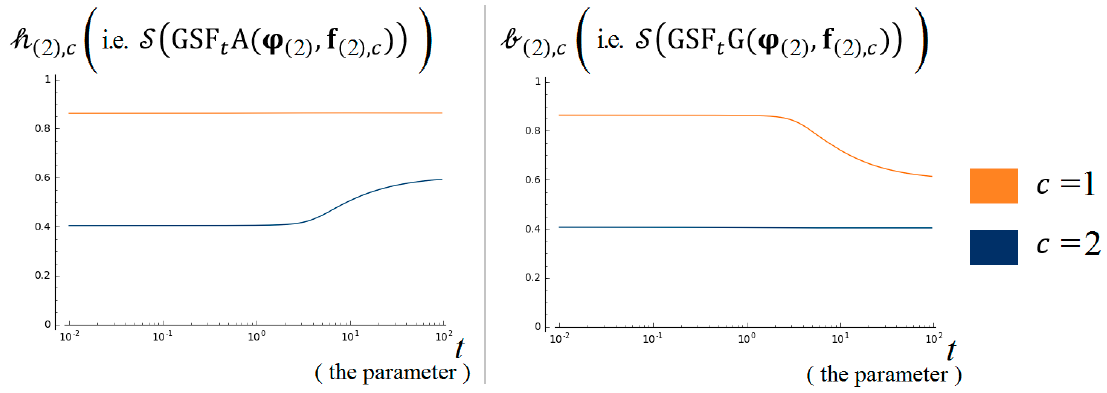
Figure 5. The results of our algorithms GSF (cid:3047) A and GSF (cid:3047) A for compliance of Test 2